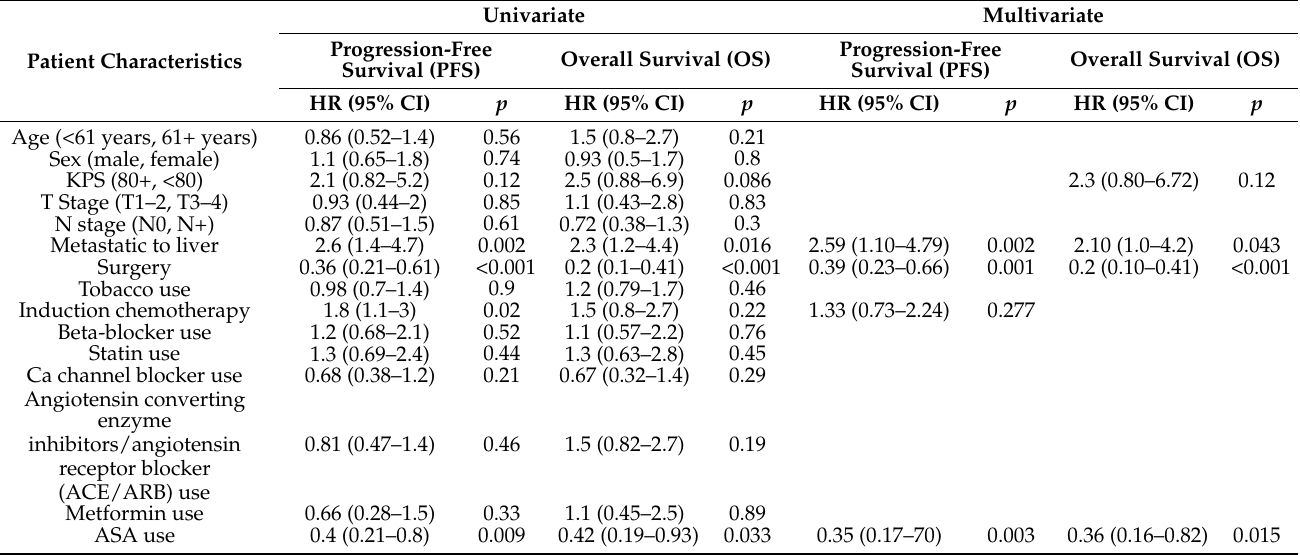
Table 3. Univariate and multivariate Cox regression